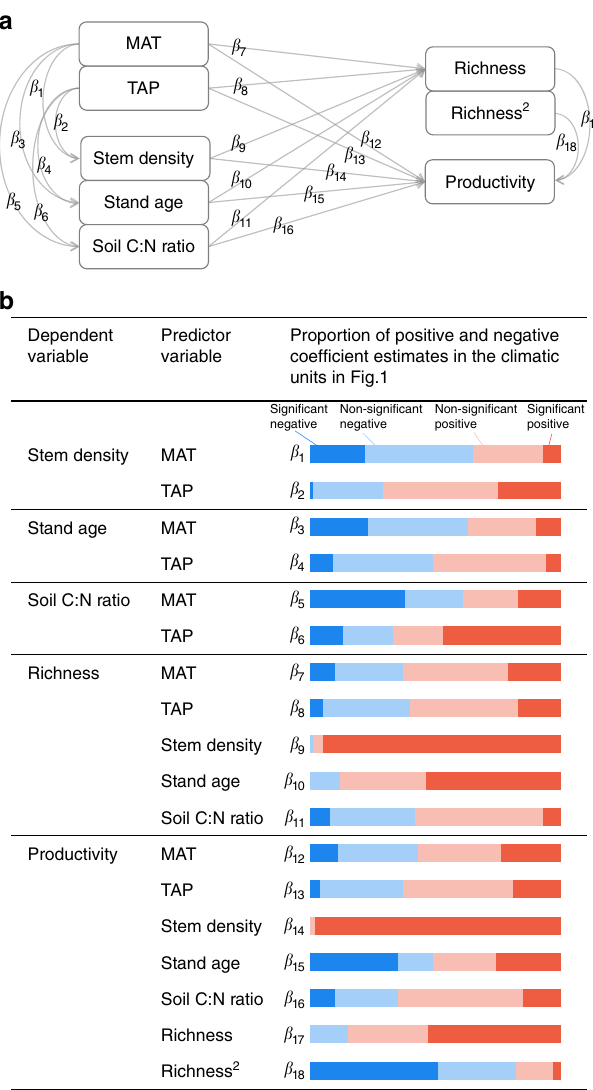
Fig. 2 A hierarchical model for testing effects of environmental factors and richness on productivity. a Model structure and b proportions of positive and negative coef fi cient estimates ( β s) across the climatic space.